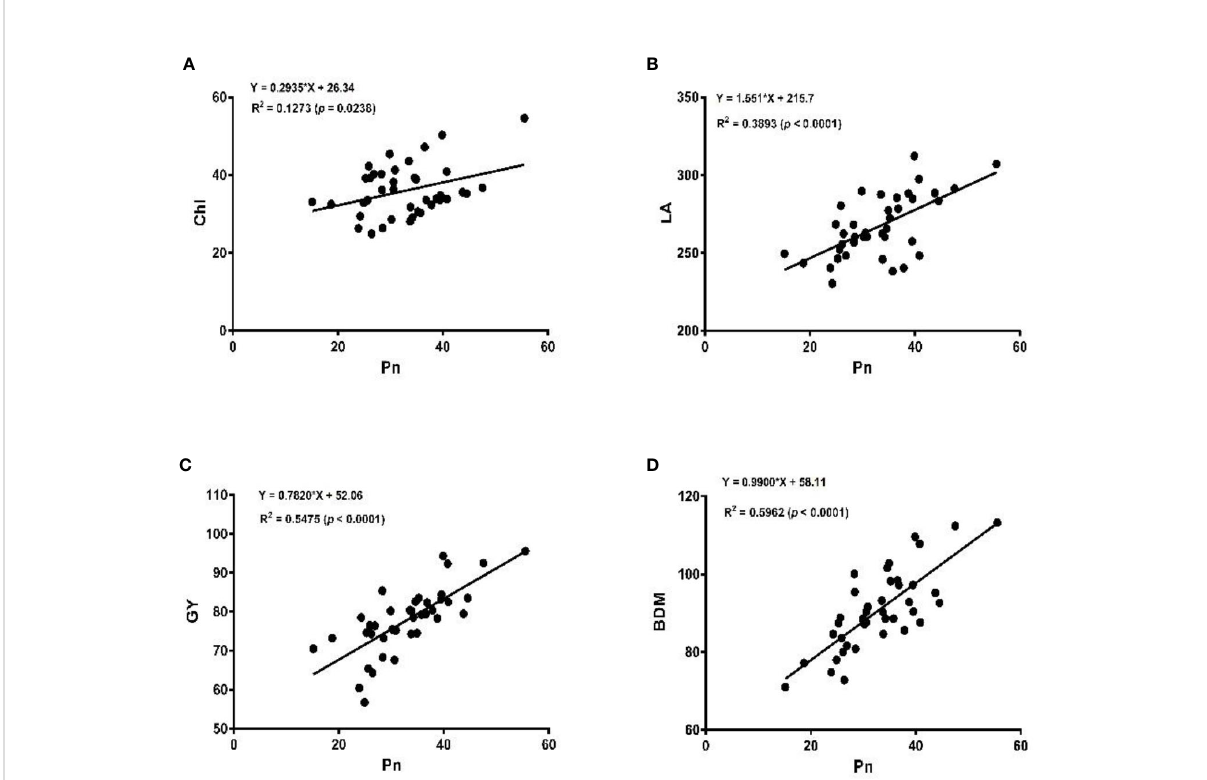
FIGURE 6 Linear regression of photosynthetic rate (Pn), with chlorophyll content (Chl) (A) , leaf area (LA) (B) , grain yield (GY) (C) , and biomass dry matter (BDM) (D) of the soybean